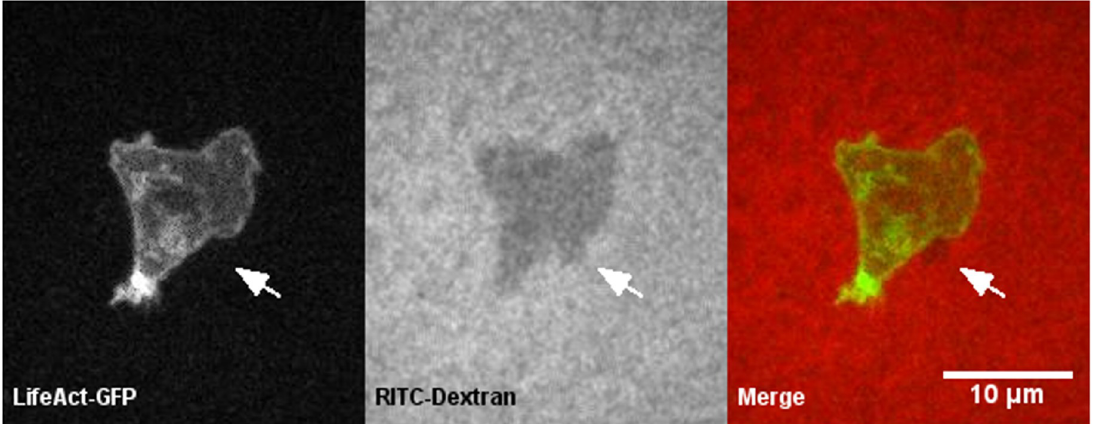
Fig 2. The under agarose assay simultaneously visualized cortex-to-membrane positions of a putative bleb. A single time point of a wild-type cell crawling under 0.5 percent agarose gel is shown. Left, LifeAct-GFP labeled the cortex’s position as well as other actin structures. Center, the RITC-Dextran in the gel was blocked by the cell, providing the cell’s edge and, therefore, membrane position. Right, a merge of the two channels provided cortex-to-membrane position where LifeAct-GFP and RITC-Dextran were false colored green and red, respectively. A putative bleb lacking actin structures was observed observed (white arrow).